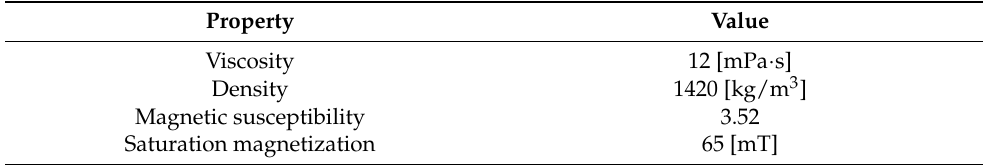
Table 3. Ferrofluid property data.